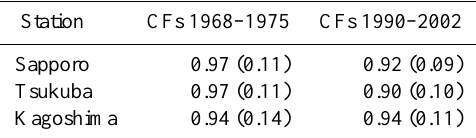
Table 5. Comparison of CFs at three Japanese stations for the periods 1968–1975 and 1990–2002, after (Hasebe and Yoshikura,